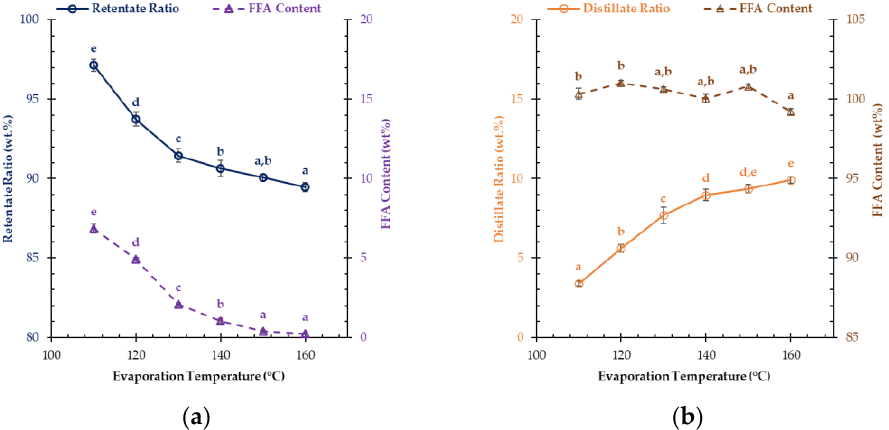
Figure 3. Mass ratio and FFA content in ( a ) retentate and ( b ) distillate recovered from 10 wt.% FFA in feeding mixture at various evaporation temperatures. Different letters indicate significant differences at p < 0.05 .